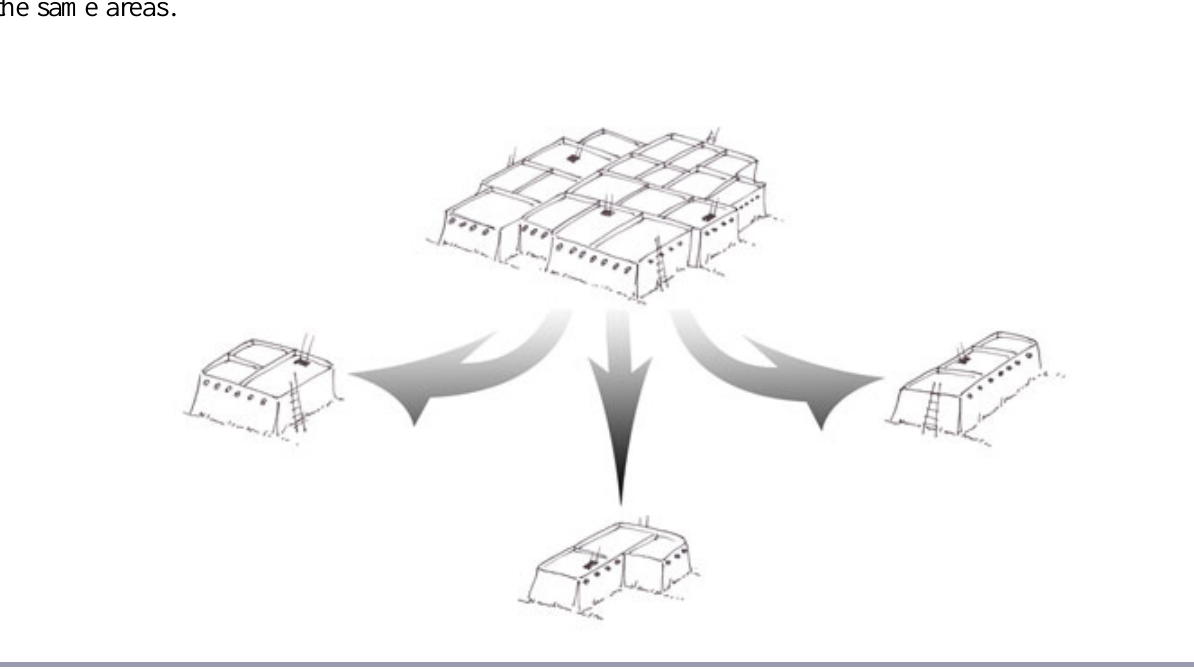
Fig. 11 . At the end of the Mimbres Classic Period (1130 CE) all villages in the Mimbres region were depopulated. In the eastern Mimbres subregion, people shifted to small hamlet settlements, remaining in the same